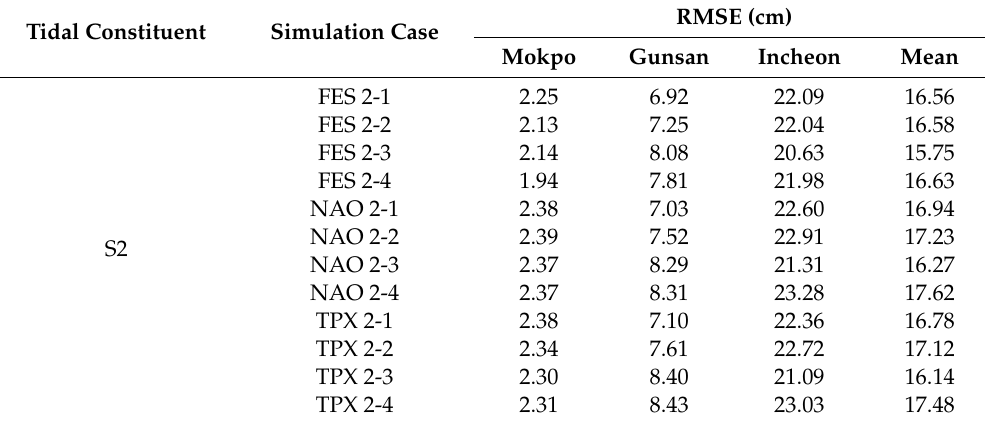
Table A8. RMSE results obtained from non-uniform roughness bottom for S2. Tidal Constituent